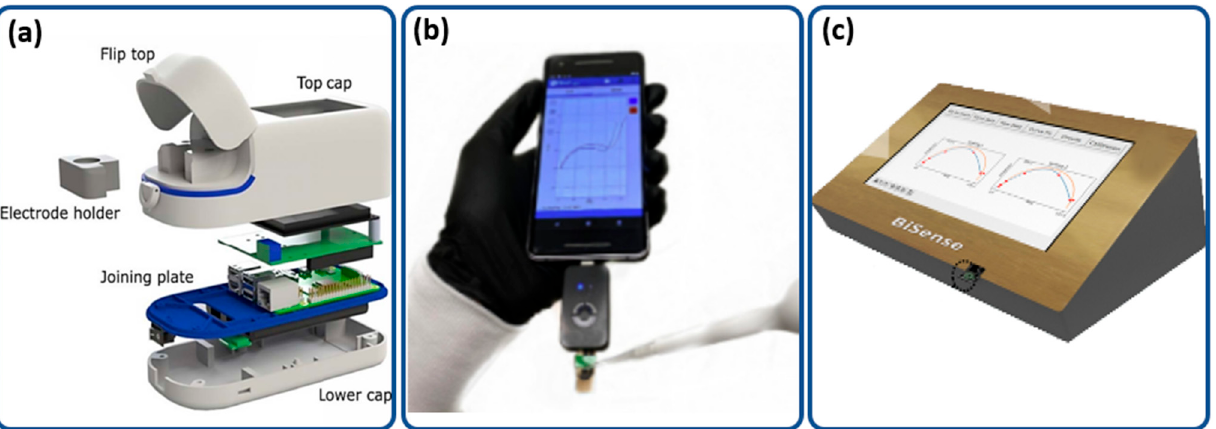
Figure 7. ( a ) Expanded view of the SenSARS portable device [86]. ( b ) PalmSens Sensit module used by Torres et al. (2021) [89]. ( c ) 3D rendering of the Bisense system [90].